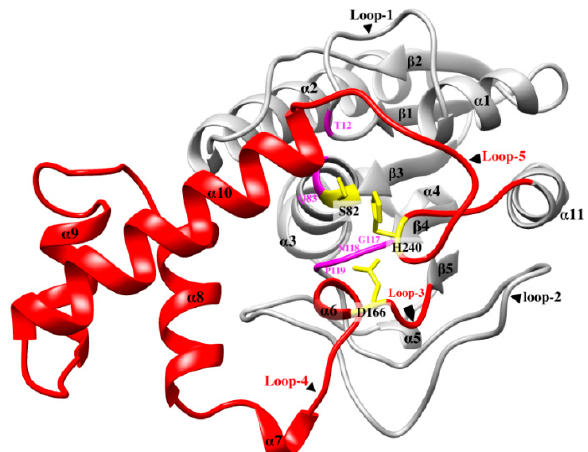
Figure 1. Crystal structure of LysB-D29 showing secondary structure elements including linker domain (red color), catalytic triad residues (yellow), oxyanion hole residues, and GNP residues (pink), and the rest of the protein (gray).